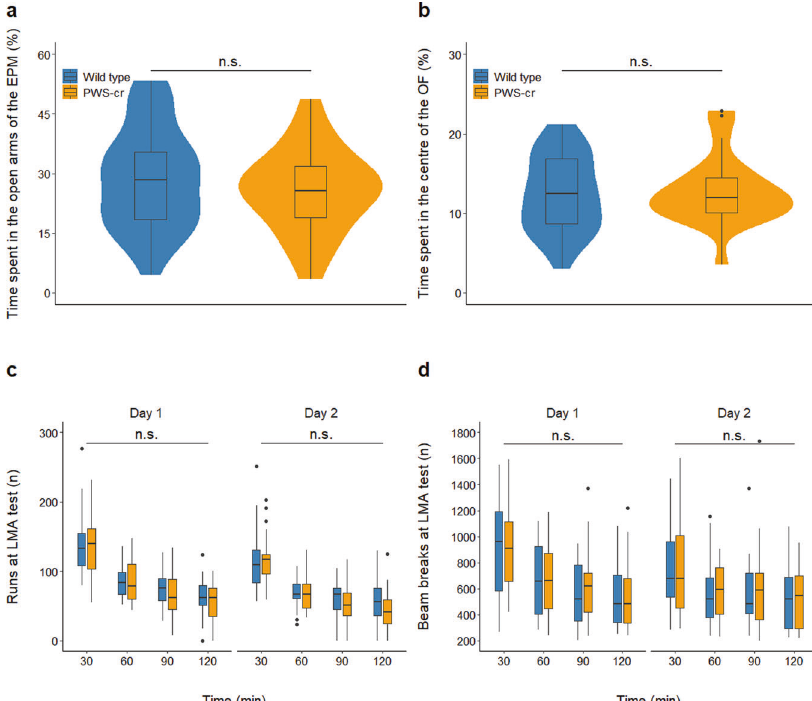
Fig. 1 Behaviours recorded at the elevated plus maze, open fi eld arena and locomotor activity test. The elevated plus-maze task ( a ) showed no effect of genotype on the percentage of time spent in the open arms of the maze (PWS-cr = 23, WT = 31). Similarly, data from the open fi eld test ( b ) showed no difference in the percentage of time spent in the centre square of the arena between PWS-cr mice ( n = 23) and their wild-type littermates ( n = 31). Locomotor activity was tested in custom-made chambers with fi tted infrared beams, which tracked the movement of the animals in two-hour sessions on two consecutive days. The number of beam breaks ( d ) and the number of runs from one end of the chamber to the other ( c ) were considered the main measures of activity. The test showed decreased locomotor activity between and within sessions ( p < 0.001), which is indicative of habituation to the environment. There was no effect of genotype on the behaviour examined by this test (PWS-cr = 23, WT =